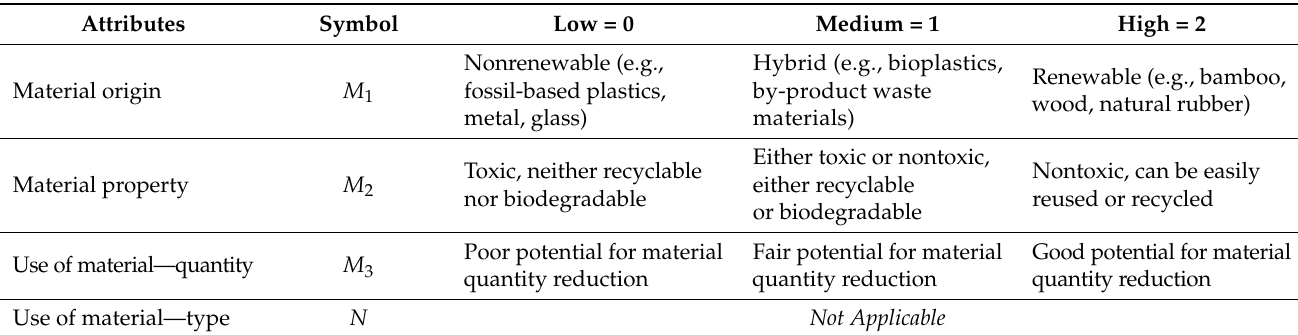
Table 2. Attributes for measuring concept material